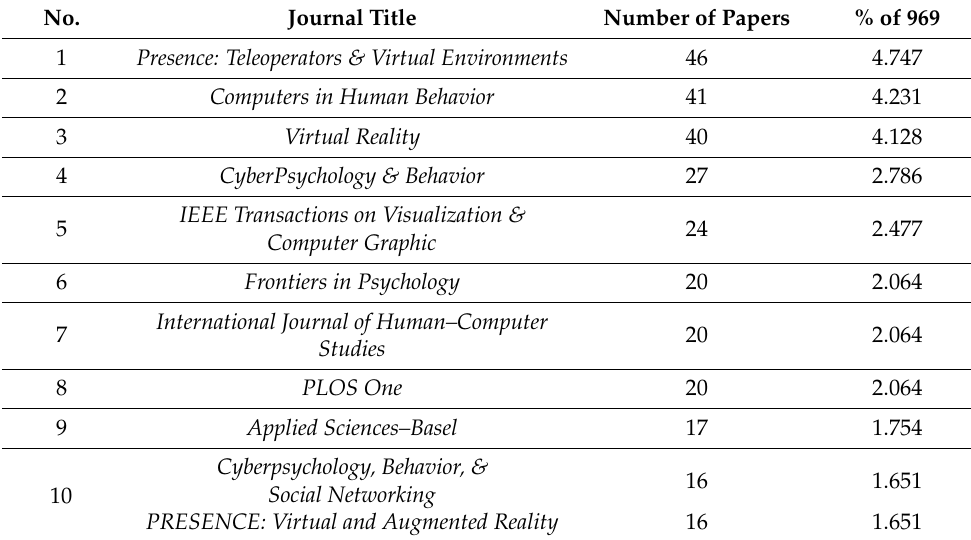
Figure 2. Most prolific journals via WoS. Table 3. The top 10 most prolific journals.